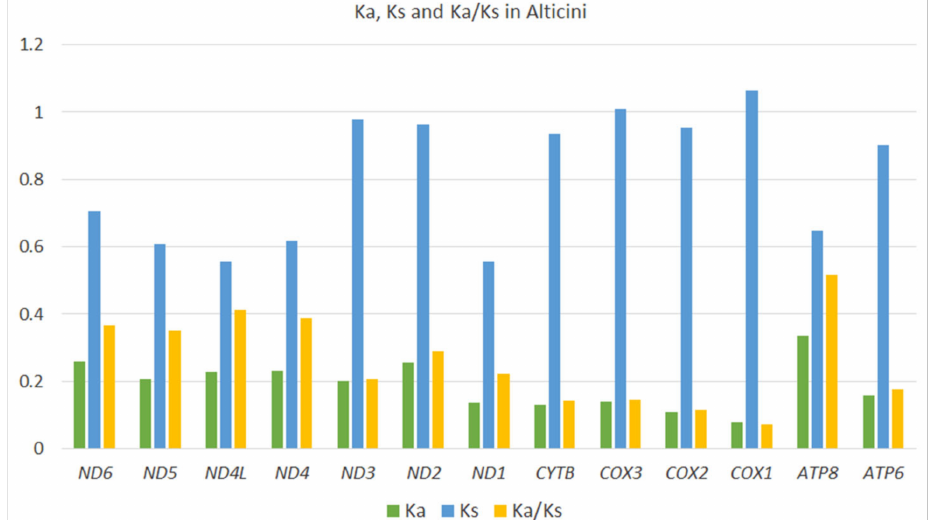
Figure 7. Evolutionary rates (Ka/Ks) of 13 mitochondrial protein-coding genes of 64 species of Alticini (Coleoptera: